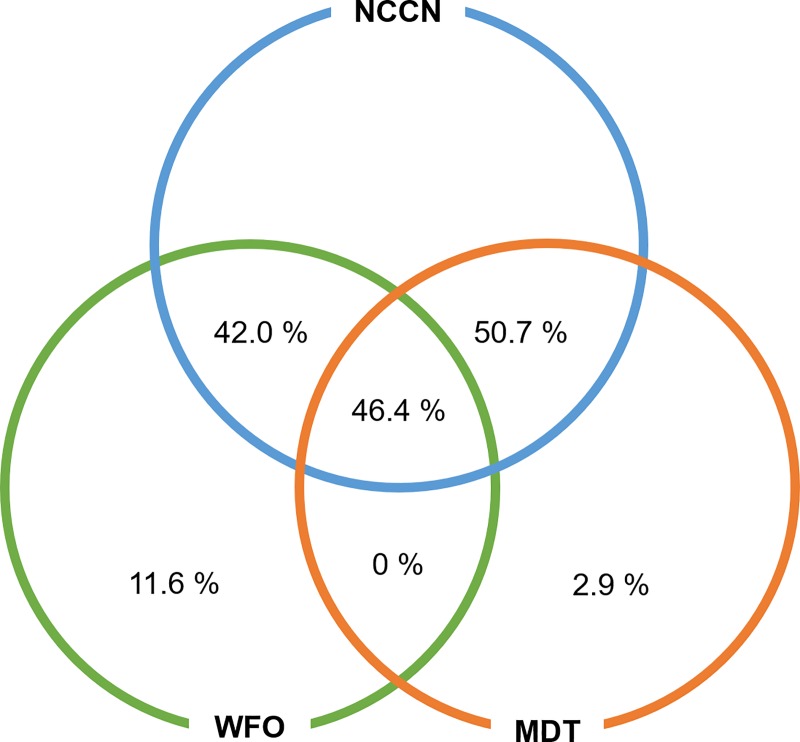
Diagram of the concordance rates.The WFO ‘Recommended’ treatment option and MDT recommendation.